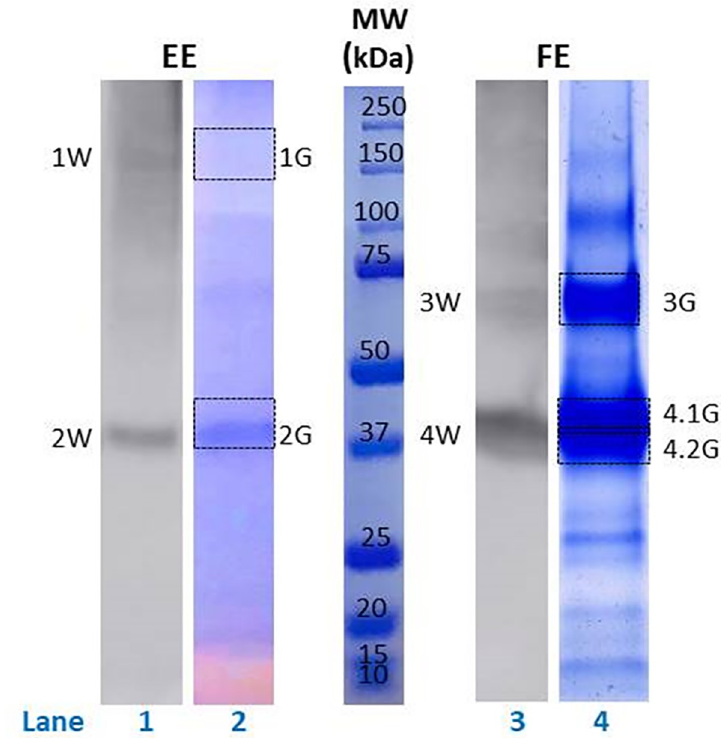
Fig 2. Major immunogenic proteins detected in T . trichiura extracts. Western blot showing AGMs sera antibodies response to T . trichiura egg extract (EE) (Lane 1) and female extract (FE) (Lane 3) (10 μ g/lane). Bands 1W-2W and 3W-4W indicate the regions containing antigens recognized most strongly by sera antibodies in EE and FE, respectively. Corresponding SDS-PAGE of EE (Lane 2) and FE (Lane 4), stained with Coomassie Brilliant Blue R-250 and excised areas of each, 1G-2G and 3G-4.1G-4.2G, containing the most immunogenic peptides for proteomic analysis. Molecular weight in kDa is lane labeled as MW.